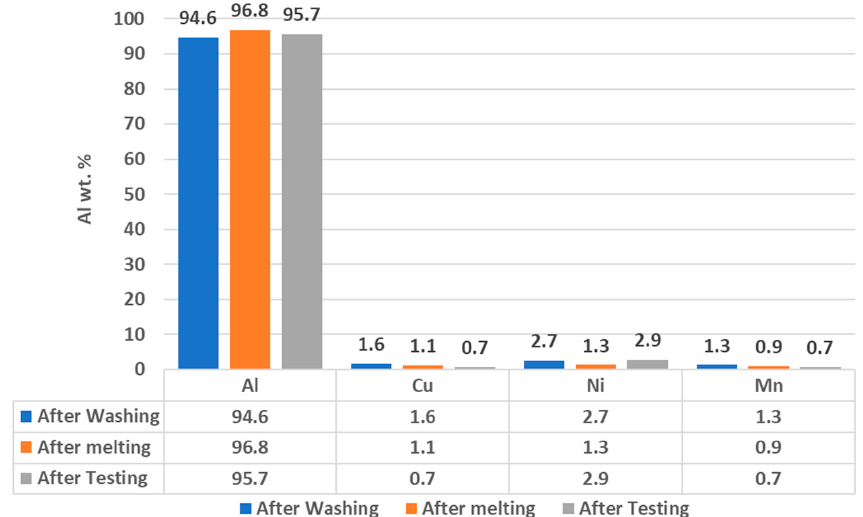
Figure 7. EDX test results on the surface of Al CCs after washing, melting, and battery testing.